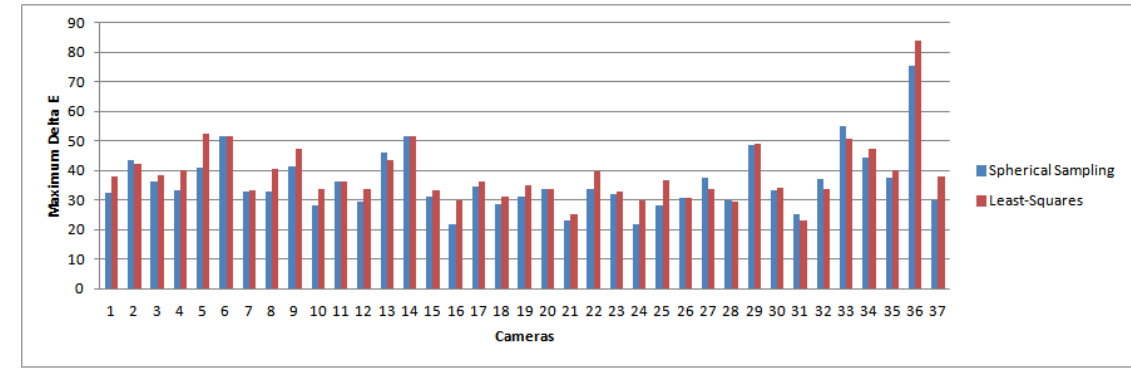
Figure 6. Maxima per camera for both spherical sampling (blue) and least-squares